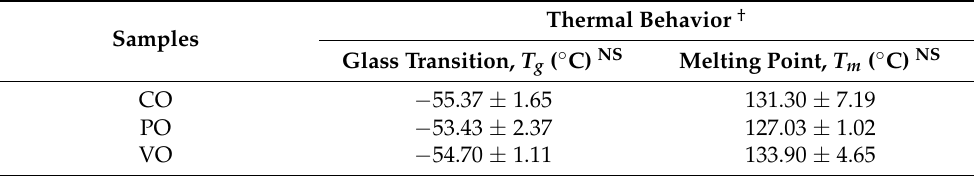
Table 6. Thermal properties of date syrups prepared using different extraction methods followed by evaporation using open heating.